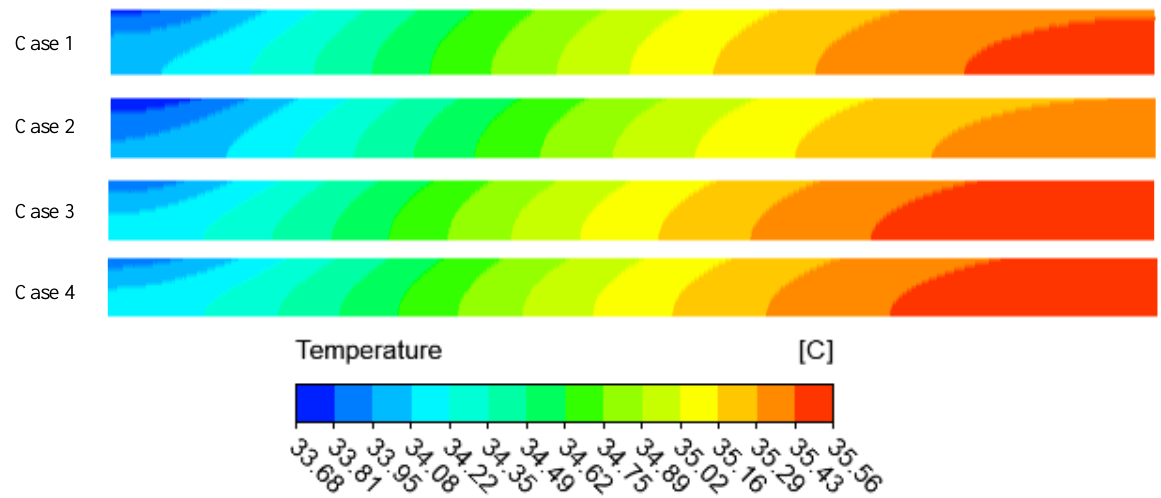
Figure 11. Temperature distribution in the battery for different cases for inlet airflow of 0.412m/s at 27ºC after